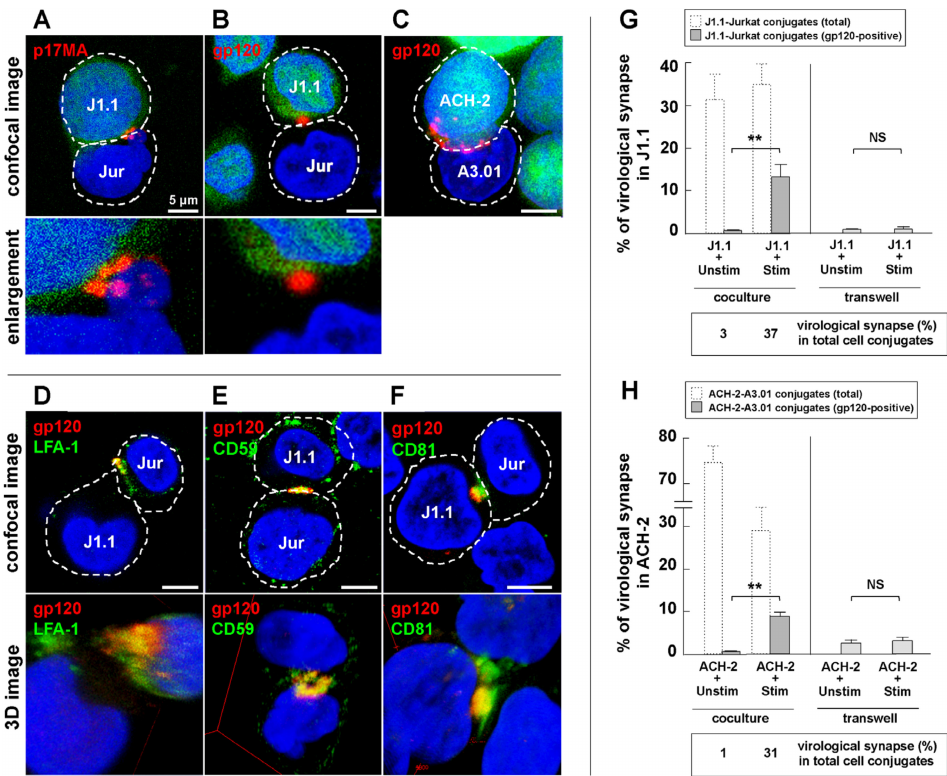
Figure 4. Formation of HIV-1 virological synapse-like structures at the interface of latently infected and uninfected cells. ( A,B,D–F ) Localization of HIV-1 proteins and host proteins at the J1.1–Jurkat cell interfaces. J1.1 cells were prelabeled with CellTracker and were cocultured with stimulated Jurkat cells. At 3 days post coculture, the cells were immunostained with anti-HIV-1 p17MA mAb (red), anti-HIV-1 gp120 Ab (red), anti-LFA-1 α mAb (green), anti-CD59 mAb (green), and anti-CD81 mAb (green). Lower panels in ( D – F ) show 3D reconstruction images. ( C ) Localization of HIV-1 gp120 at ACH-2–A3.01 cell interfaces. ACH-2 cells were prelabeled with CellTracker and were cocultured with stimulated A3.01 cells. At 1 day post coculture, the cells were immunostained with anti-HIV-1 gp120 Ab (red). Nuclei were costained with DAPI (blue). Representative images were shown. Scale bar, 5 µ m. ( G ) Formation of virological synapse-like structures in J1.1–Jurkat cell coculture. J1.1 cells were prelabeled with CellTracker and were cocultured with unstimulated or stimulated Jurkat cells with cell contact. At 3 days post coculture, the cells were immunostained with anti-HIV-1 gp120 Ab and were subjected to quantification for the formation of virological synapse-like structures. The rates of J1.1–Jurkat cell conjugates with HIV-1 gp120 antigens at the cell interfaces in J1.1 population were calculated (solid grey columns). The rates of J1.1–Jurkat cell conjugates in J1.1 population (100–150 J1.1 cells) were also shown (dashed columns). E ffi ciency of formation of virological synapse-like structures in J1.1–Jurkat cell conjugates was shown as percentage of the gp120-positive J1.1–Jurkat cell conjugates